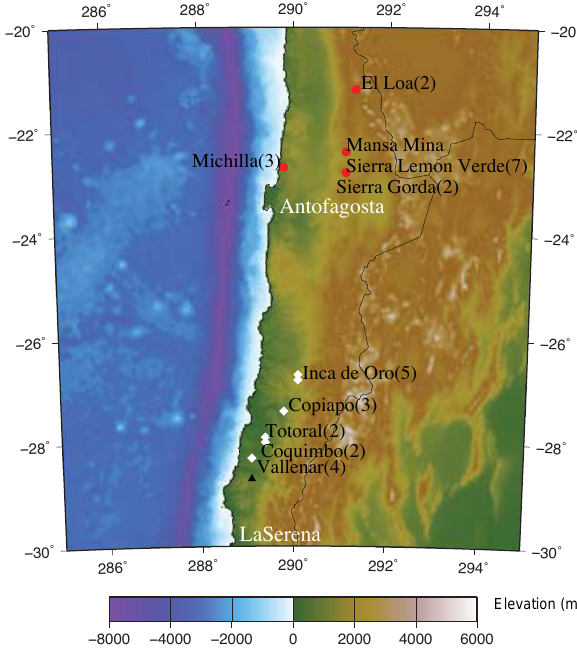
Figure 2. Map of northern Chile with locations of boreholes used in this study. The number of boreholes at each site is indi- cated in parentheses. Red circles indicate borehole temperature– depth profiles measured in 1994, black triangles are measured in 2012, and white diamonds are measured in 2015. Sites with bore- hole temperature–depth profiles deemed suitable for climate are Michilla, Totoral, Inca de Oro, and